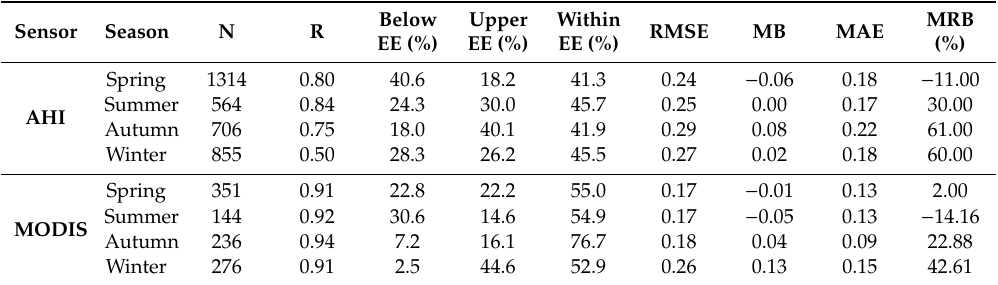
Table 3. Seasonal comparison of AHI and MODIS AOD retrievals against AERONET observations in China from February 2018 to January 2019.